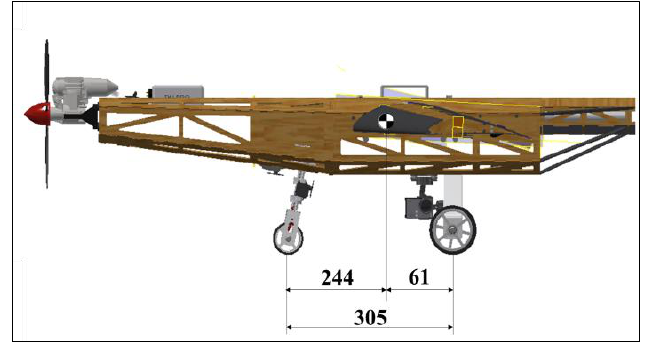
Figure 6: Landing gear